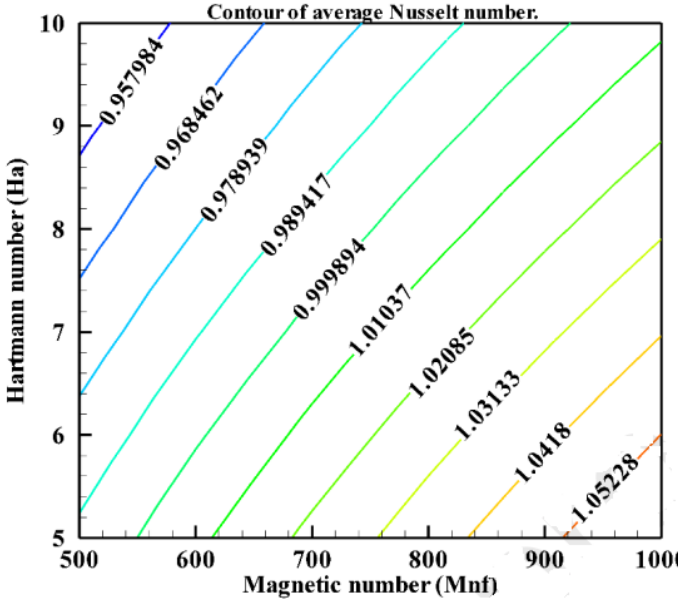
Figure 18. The contours of the average Nusselt number in Ra = 10 3 for different magnetic and Hartmann Numbers. Reprinted with permission from Ref. [29]. 2020, Elsevier.